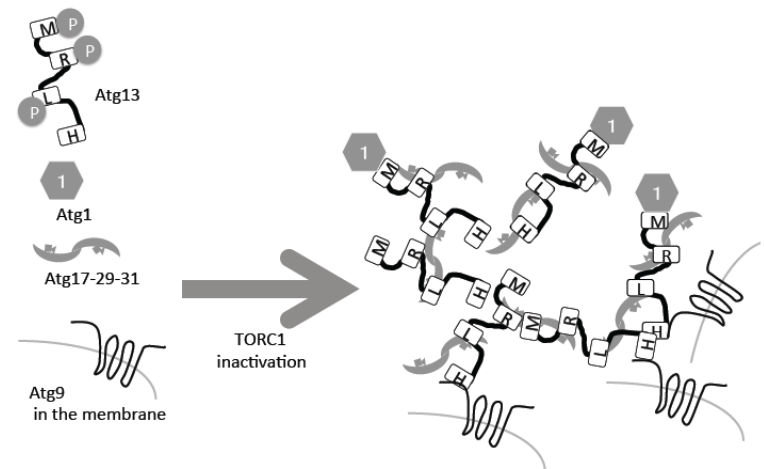
Figure 1. Autophagy related gene 13 (Atg13) dephosphorylation leads to preautophagosomal structure (PAS) formation. Atg13 is phosphorylated by target of rapamycin complex 1 (TORC1), and inactivation of TORC1 leads to its dephosphorylation, resulting in PAS formation. For details, please see the text. H: HORMA domain; R: Atg13-17BR; L: Atg13-17BL; M: MIM domain.